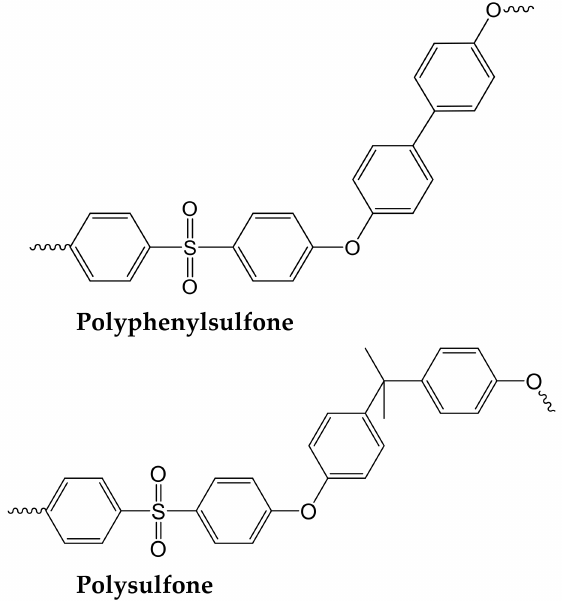
Figure 1. Chemical structure of the polymers used in this study. Polyethylene glycol (PEG-400, BASF, Ludwigshafen, Germany) with M n = 400 g · mol − 1 was used as the additive to the polymer solution, and NMP (EKOS-1, Russia) was utilized as the solvent without any further